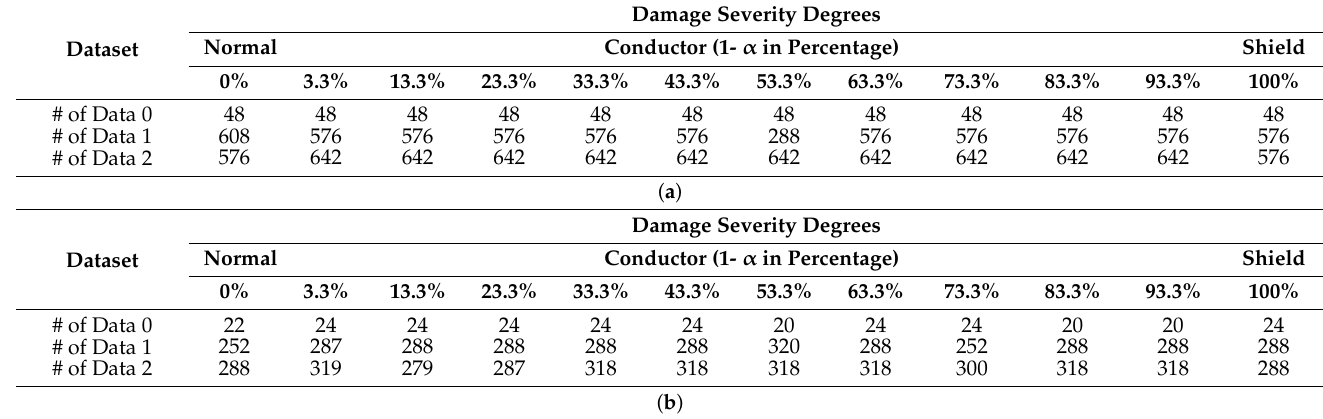
Table 2. The number of collected datasets for Data 0, Data 1, and Data 2. Each dataset is measured according to the 3 scenarios from Figure 14: ( a ) offline data set; ( b ) online data set.